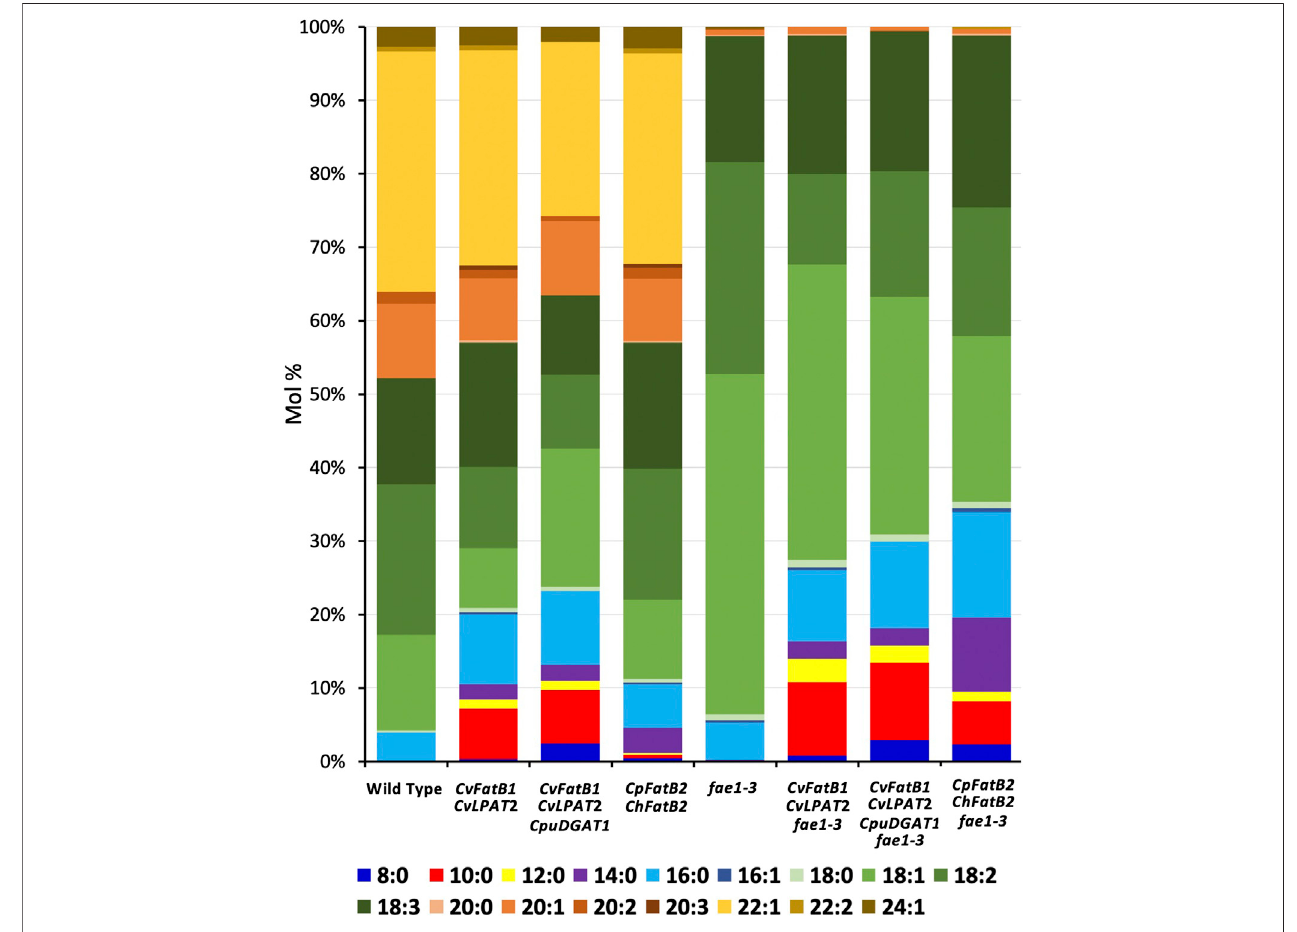
FIGURE5| Comparison ofseed TAGFAamountsin transgenic lines stackedwith an fae1-3 knockoutmutationcomparedtotheparentallines. AverageFA mol% amounts along with standard deviations are shown in Table 1 .